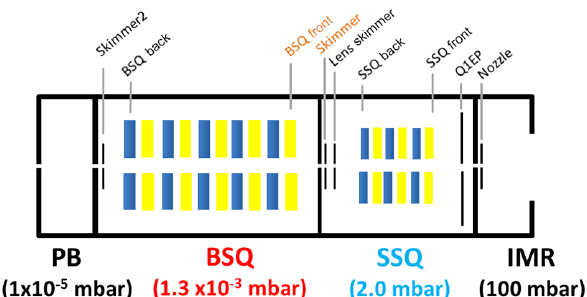
Figure 1. Schematic of the Tofwerk atmospheric pressure interface (API) showing where the IMR mounts on the API, the short seg- mented quadrupole (SSQ), the big segmented quadrupole (BSQ), and the primary beam (PB)